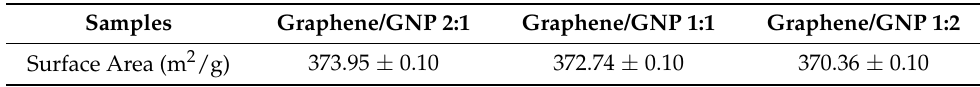
Figure 3. FT-IR peaks of ( a ) GO with different GNP ratios and ( b ) rGO/GNP. ( c ) Graphene aerogels BET peaks and ( d ) pore size distribution of the samples. SEM images of ( e ) 2:1 ratio rGO/GNP aerogel, ( f ) 1:1 ratio rGO/GNP aerogel and ( g ) 1:2 rGO/GNP aerogel. Table 1. BET results of rGO/GNP aerogels with different